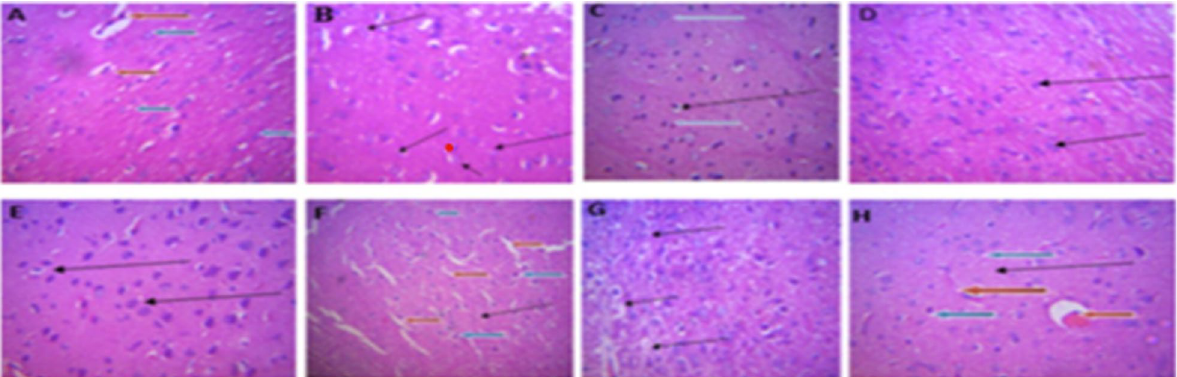
significantly different compared with the =